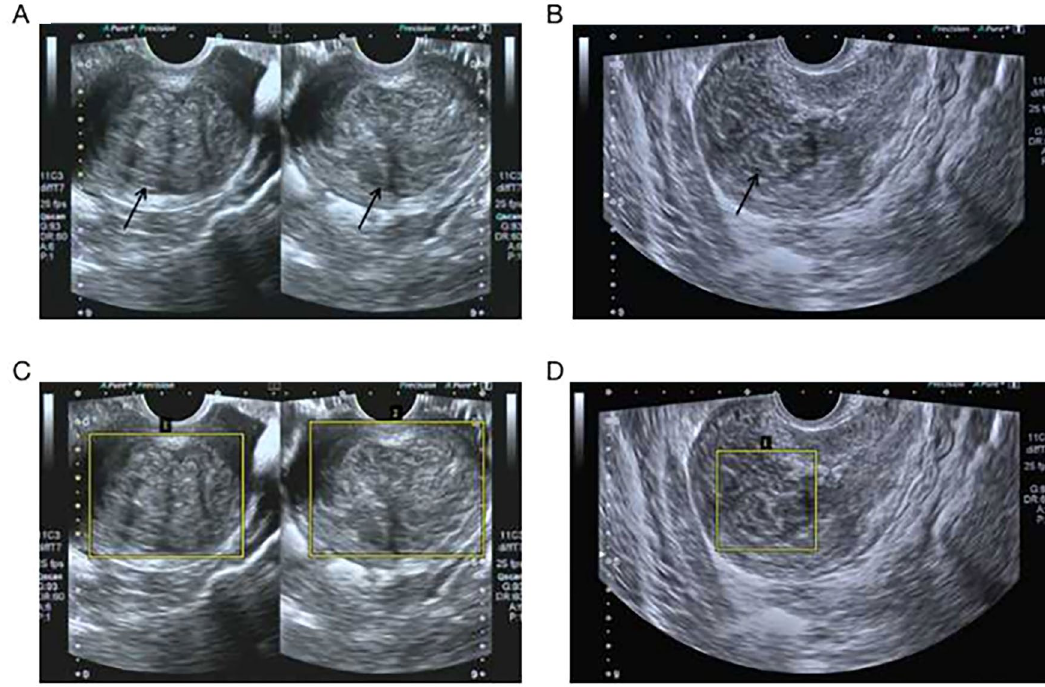
Figure 2. Examples of original ultrasound data and sample data after labeling. ( A ) Training sample of ultrasound image with two uterine fibroids. ( B ) Training sample of ultrasound image with one fibroid. ( C ) Labeled training sample of ultrasound image with two uterine fibroids. ( D ) Labeled training sample of an ultrasound image with only one fibroid. The yellow box shows the extent of fibroids marked by the